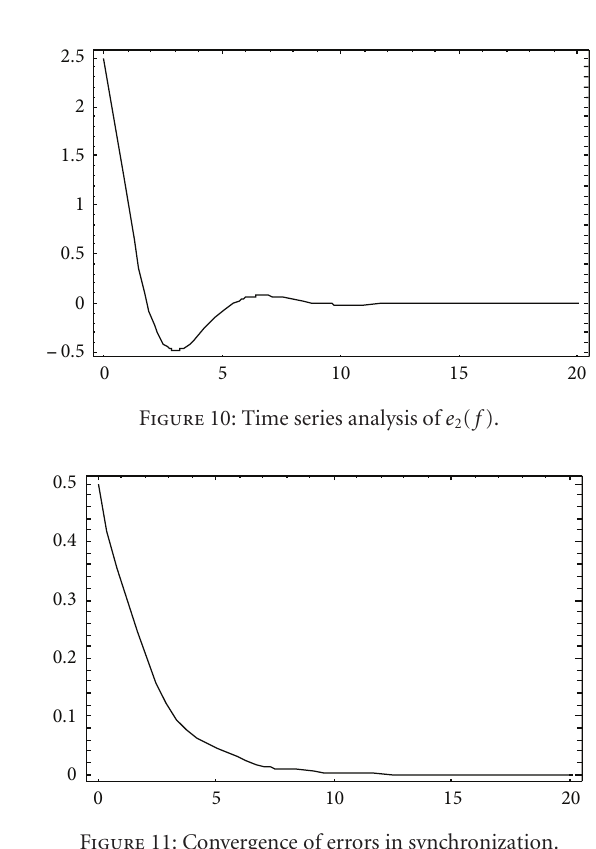
Figure 11: Convergence of errors in synchronization.